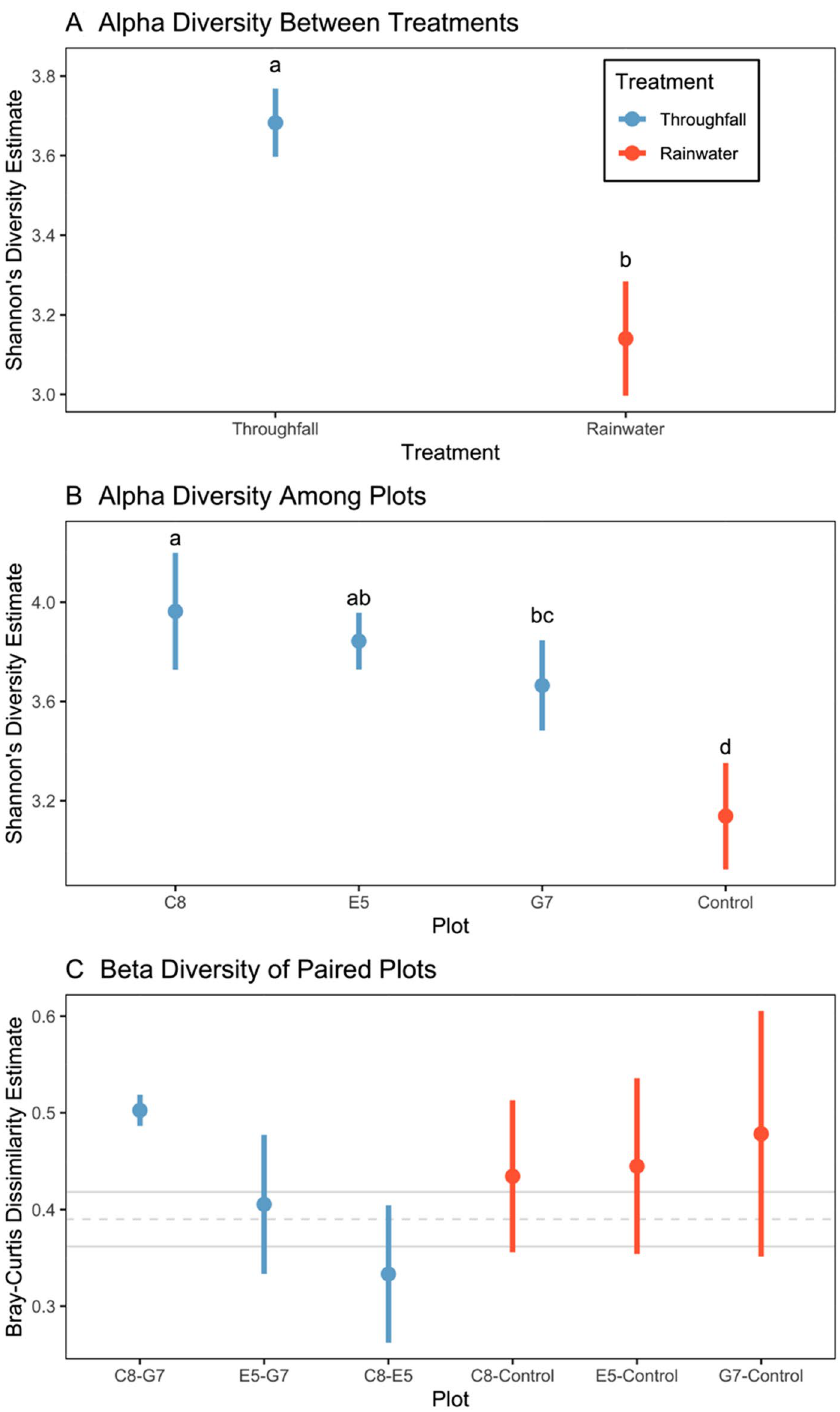
Figure 4. Community diversity indices (mean ± SE) for ( A ) Shannon’s diversity index showing comparison of alpha diversity between throughfall (blue) and rainwater (red) treatments, ( B ) alpha diversity among plots, and ( C ) Bray–Curtis dissimilarity between all unique pairs of plots, with light gray lines indicating mean and SE of community dissimilarity between throughfall and rainwater. Lowercase letters indicate significant